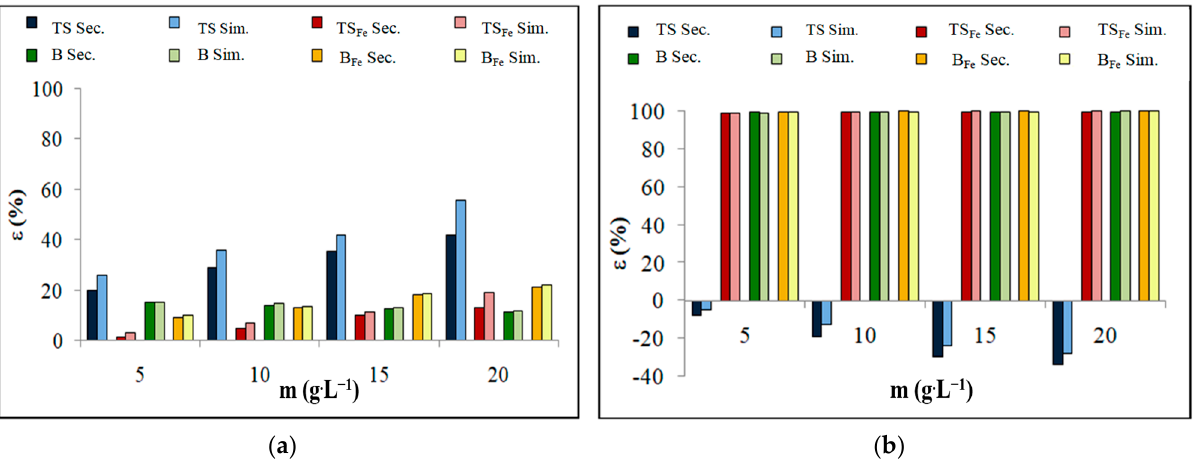
Figure 5. Adsorption efficiencies of B/B Fe and TS/TS Fe for selected ion sorption and simultaneous sorption: ( a ) NH 4+ ; ( b ) PO 43 − .